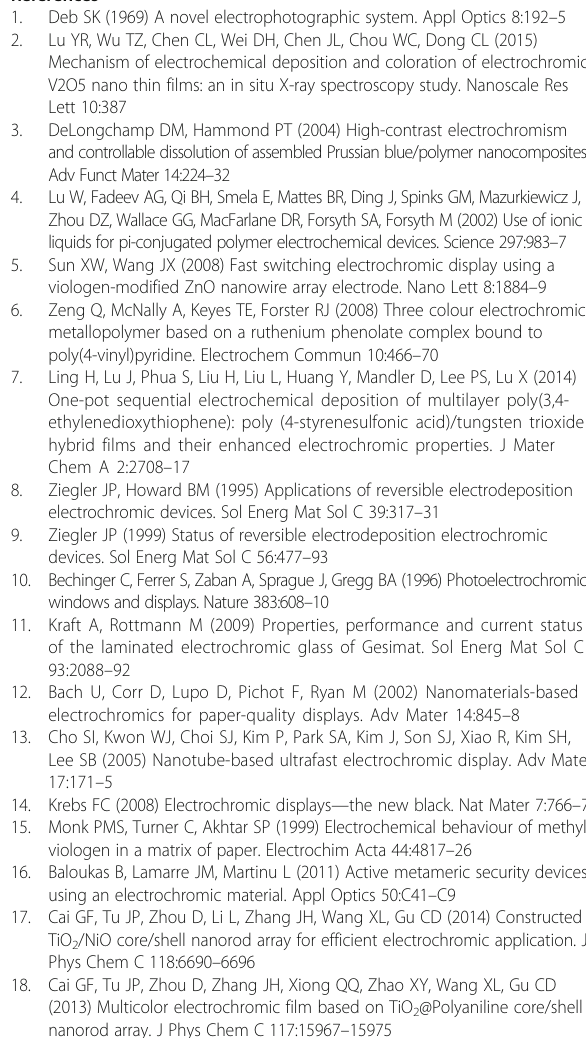
Additional file 1:Figure S1. (Color online) XRD patterns of dip-coated TiO 2 thin film (dip-coated on the FTO electrode and sintered at 500 °C for 30 min), spin-coated TiO 2 thin film (spin-coated on the FTO electrode and sintered at 500 °C for 30 min), fresh TiO 2 nanoparticles (purchased and untreated), flat FTO electrode (cleaned and dried). Figure S2. (Color online) Photographs of TiO 2 thin films after Ag deposition with nanoparticle sizes of (a) 5~10, (b) 40, and (c) 100 nm, respectively. In-plane SEM images of TiO 2 thin films after Ag deposition with nanoparticle sizes of (d) 5~10, (e) 40, and (f) 100 nm, respectively. Cross-sectional SEM images of TiO 2 thin films after Ag deposition with nanoparticle sizes of (g) 5~10, (h) 40, and (i) 100 nm, respectively. Figure S3. (Color online) SEM images of dip-coated TiO 2 thin film after switching between its coloration and bleached states for 1500 cycles. Figure S4. (Color online) Optical properties of the electrodeposition-based electrochromic device in transparent (red), black (blue), and mirror states (green). Reflectance spectra of modified devices prepared with different fabrication conditions, including (a) lifting speed of 2000 μ m/s, (b) lifting speed of 1000 μ m/s, (c) precursor concentration of 1:3, (d) precursor concentration of 1:4, (e) dipping number of 3, and (f) dipping number of 5. Table S1. Coloration efficiency (CE) of the electrochromic devices modified with different modification parameters. Table S2. Element ratios of TiO 2 thin film prepared with 100 nm TiO 2 nanoparticle after 1500 cycles. (DOCX 7367